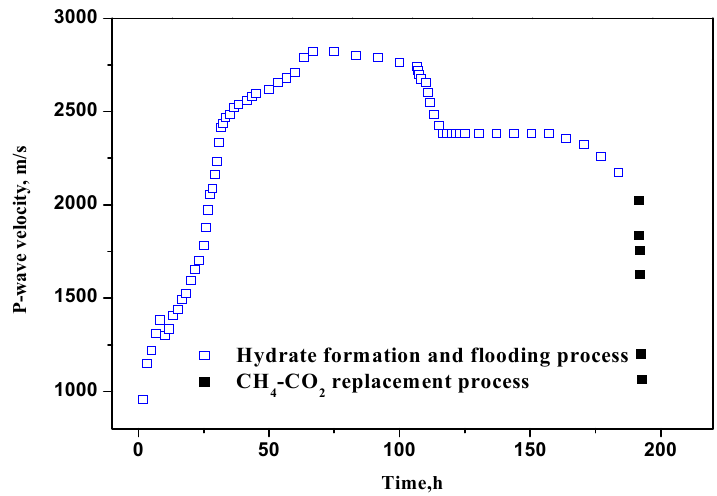
Figure 9. Variations of P-wave velocity as a function of elapsed time during methane hydrate formation and replacement process for run